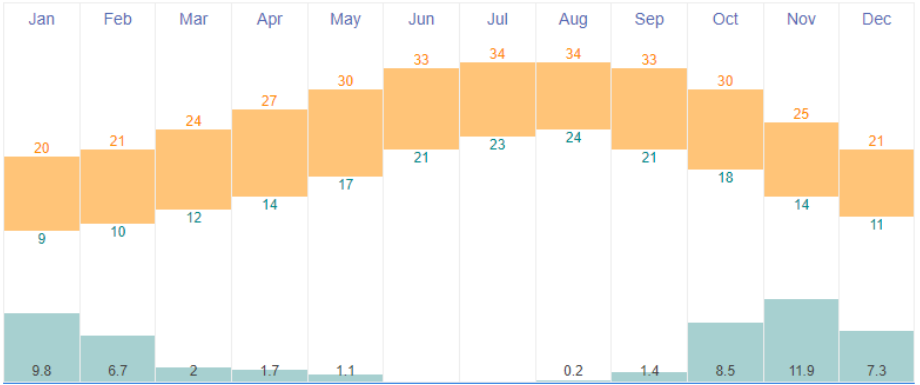
Figure 2 . Historic climate data from 2005 to 2015 of Kafr El-Sheikh Governorate area. Figure 2. Historic climate data from 2005 to 2015 of Kafr El-Sheikh Governorate